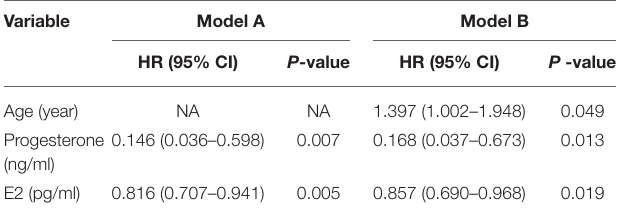
TABLE 3 | Factors associated with 30-day mortality using multivariate Cox proportional Hazard